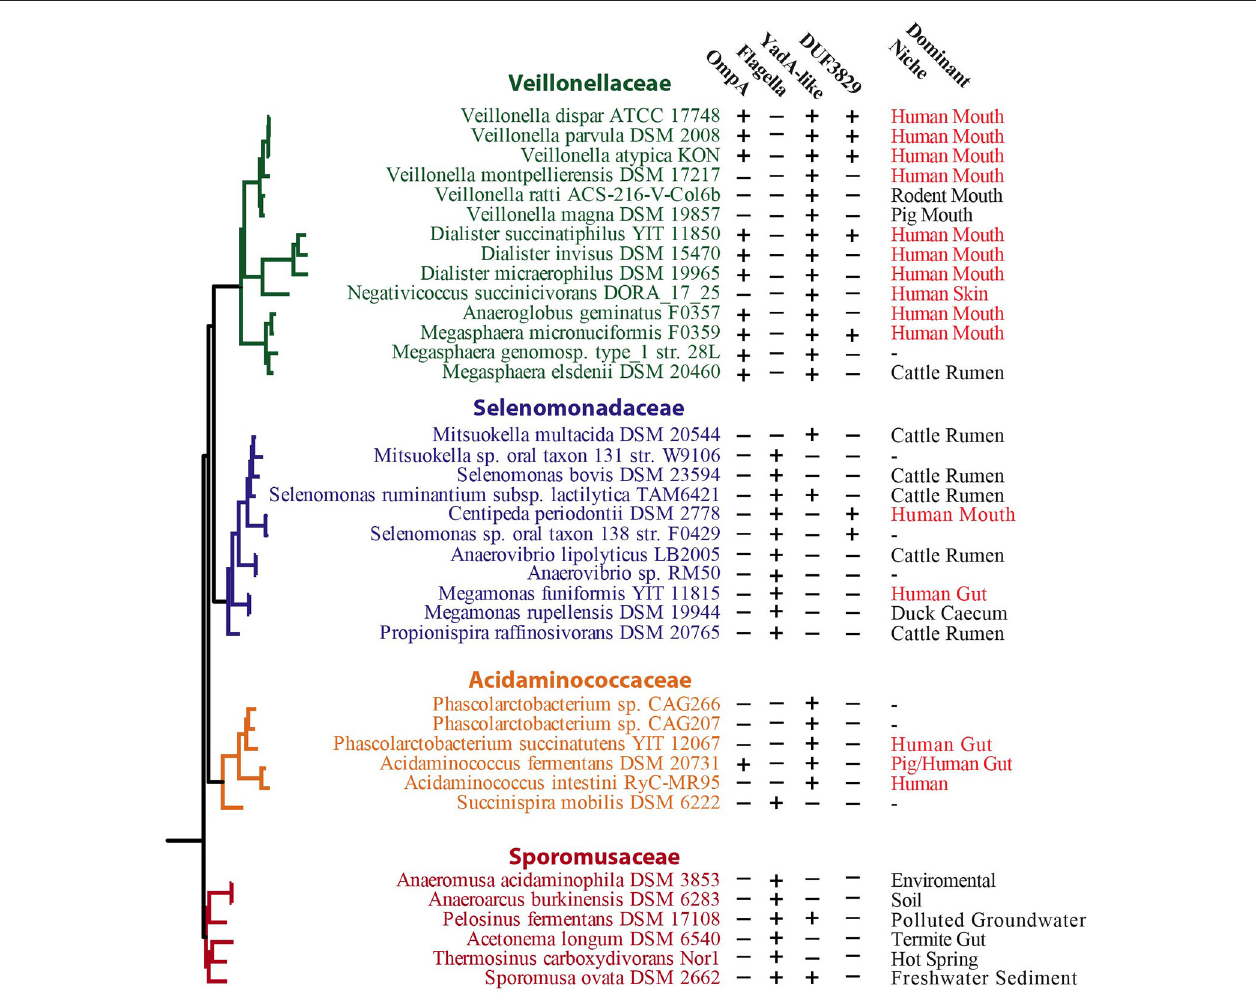
FIGURE 4 | Distribution of selected protein-coding genes in select proteins among Negativicutes. Schematic tree based on phylogeny of the Negativicutes from previous analysis (Antunes et al., 2016). Presence and absence of key genes are indicated by + and − symbols, respectively. The dominant niche of each strain taken from the available literature is also given. For discussion, see main